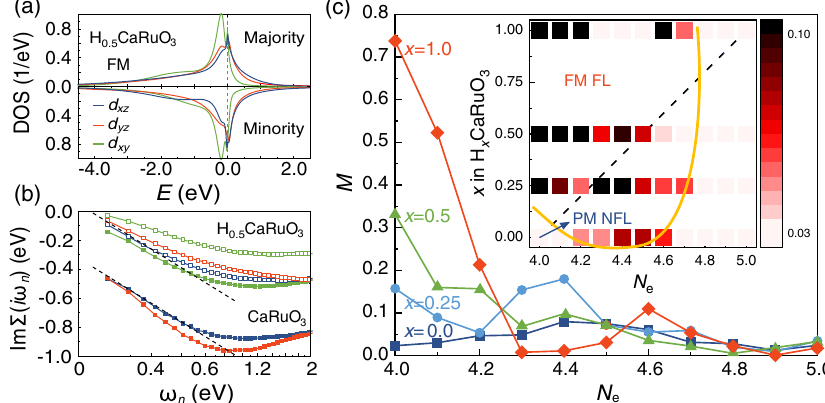
FIG. 4. Theoretically calculated phase diagram of proton intercalated H CaRuO 3 . (a) Spin polarized density of states (DOS) of x H 0 CaRuO 3 obtained through DFT þ DMFT calculations. The vertical dashed line marks the Fermi level which is taken to be the origin . 5 of the horizontal axis. (b) Imaginary part of the self-energy as a function of Matsubara frequency ω for CaRuO 3 (filled symbols) and n H 0 CaRuO 3 (open symbols). A paramagnetic state is considered for both cases. The color codes used denote different orbitals in the . 5 Þ 1 = 2 behavior. (c) Calculated Ru magnetic moment M as a function of Ru d electron same way as (a), and the dashed lines indicate ð ω n number ( N ) for pristine CaRuO 3 (blue square), H 0 CaRuO 3 (light blue circle), H 0 CaRuO 3 (green triangle), and HCaRuO 3 (red e . 25 . 5 diamond), respectively. The inset shows a summarized intensity map of magnetization ( M ) as a function of both N and x , in which the e color bar denotes M . The yellow line shows guideline for the boundary between ferromagnetism (FM) and paramagnetism (PM), while the dashed black line represents the actual protonation effect with simultaneous structural expansion and electron doping ¼ 4 þ x (as N e